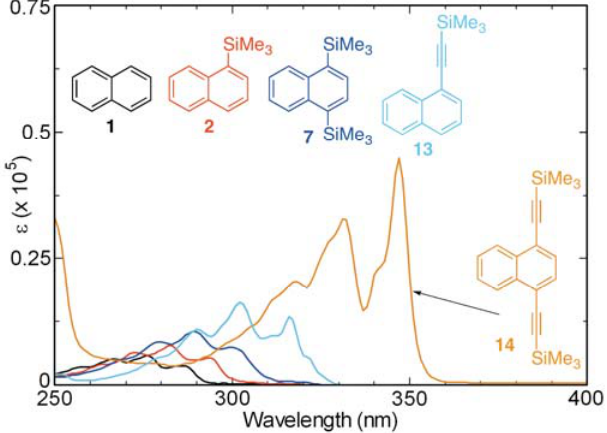
Figure 8. UV absorption spectra of 1 , 2 , 7 , 13 , and 14 in cyclohexane (aerated, 10 − 4 –10 − 5